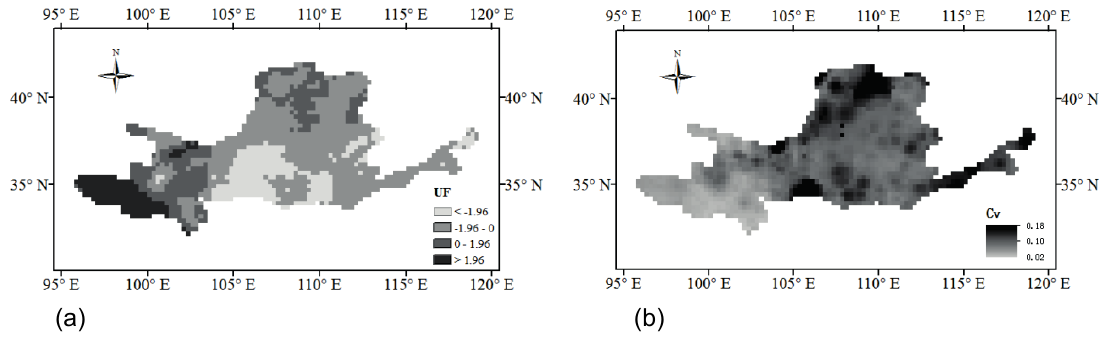
Fig. 3 (a) Spatial distribution of UF value in Mann-Kendall test, and (b) spatial distribution of deviation coefficients (Cv).